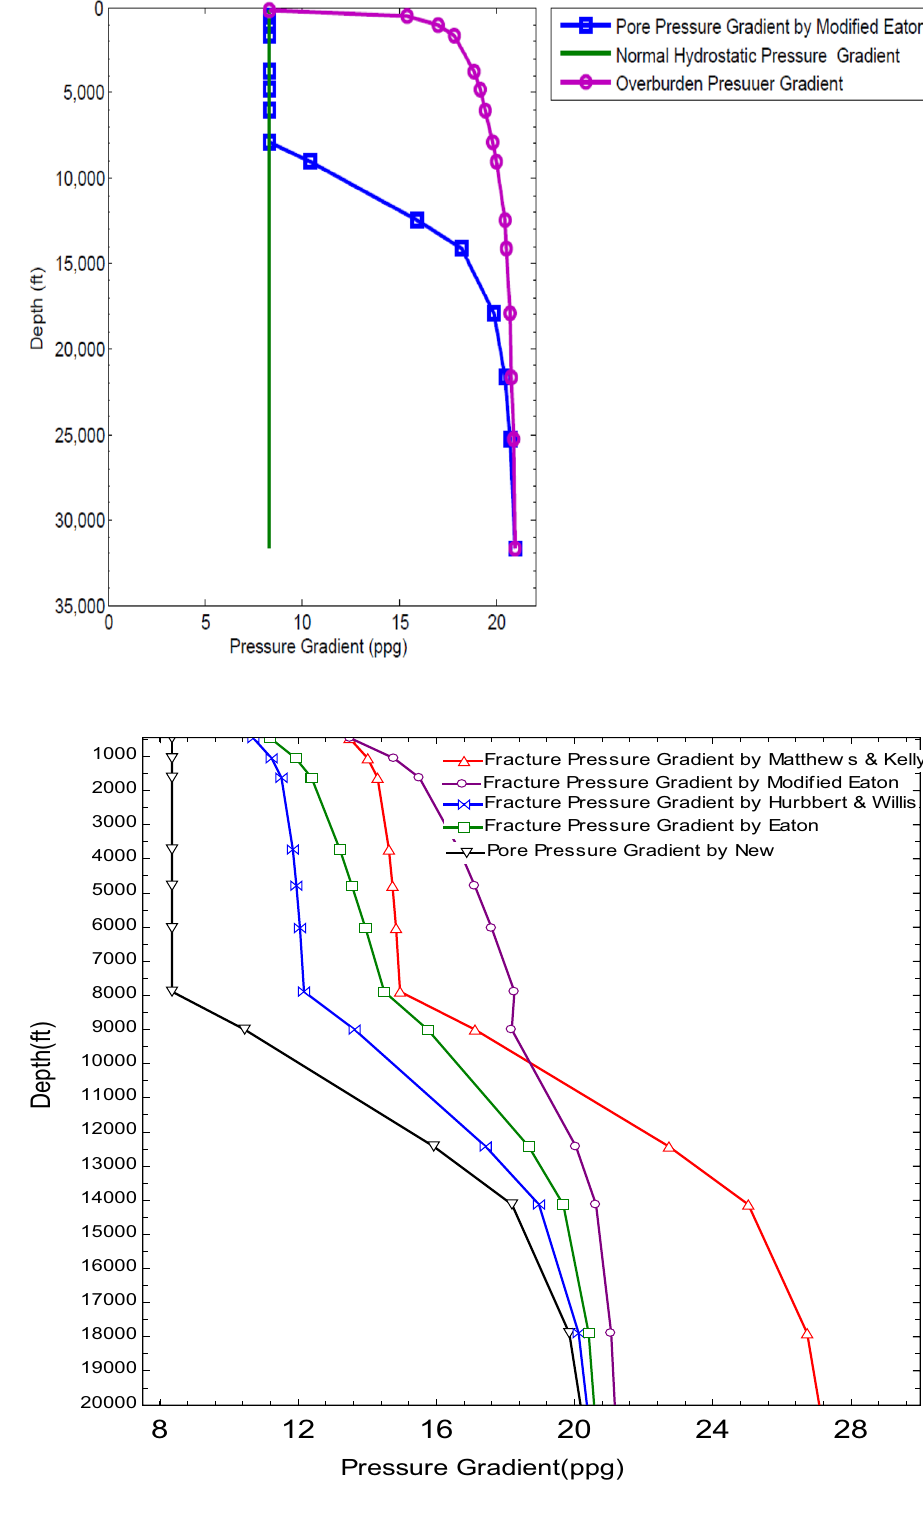
Fig. 17 Pore pressure by modi- fied Eaton’s method